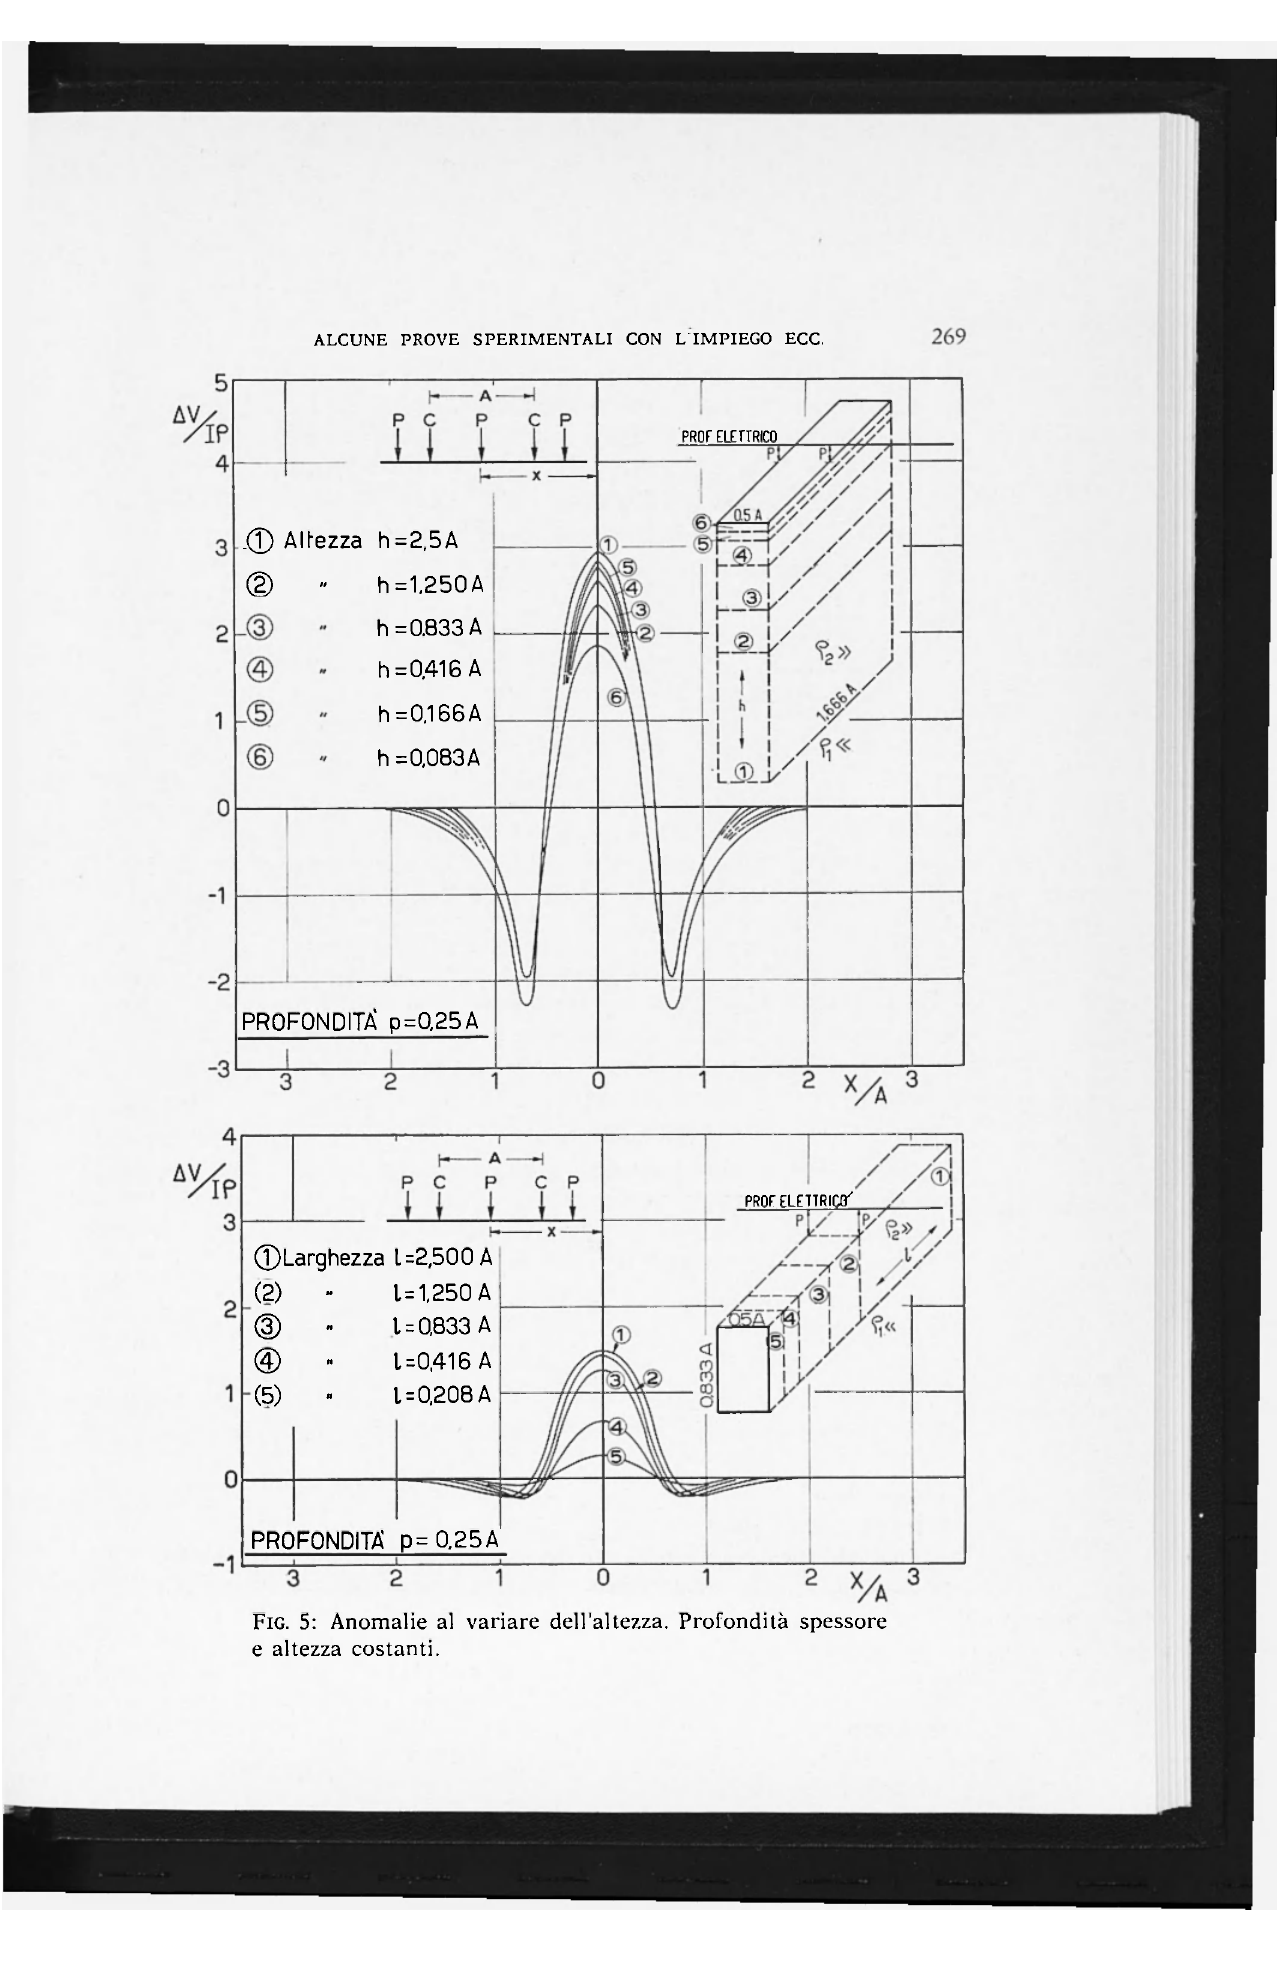
FIG. 5: Anomalie al variare dell'altezza. Profondità spessore e altezza